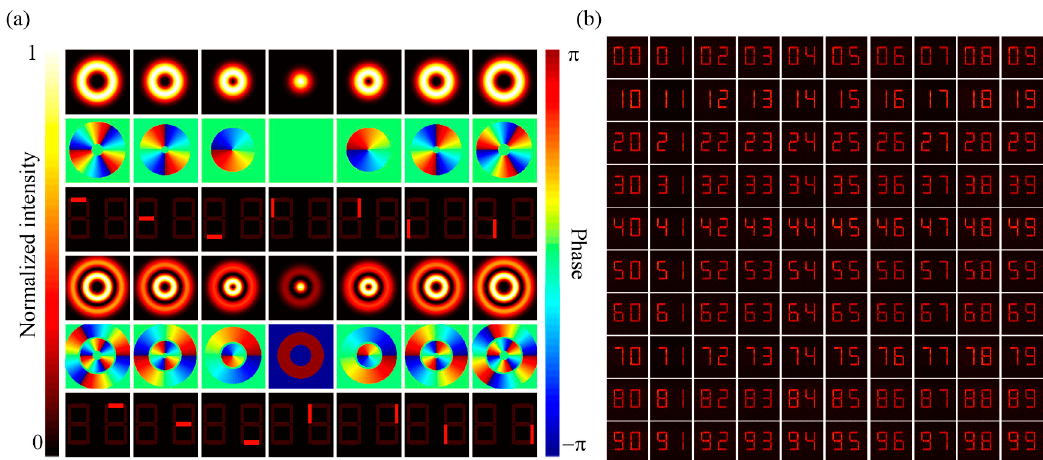
Figure 4. The numeric holographic coding based on the MPLC matrix core. ( a ) This figure summarizes the input-to-output mapping relationships between the input LG modes and the output segments of numeric display. ( b ) Results of the optical-powered numeric display from 00 to 99.